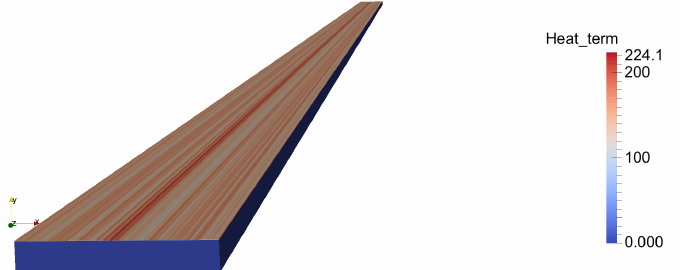
Figure 13. Heat-generation source (in W/m 3 ) for ω 1 = 2.45 GHz and the incident electric field polarized in the normal direction with respect to the fiber orientation.